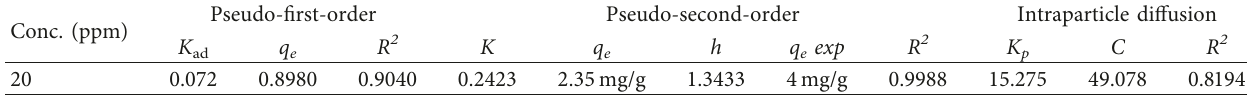
Table 3: Kinetic parameters for adsorption of dieldrin onto